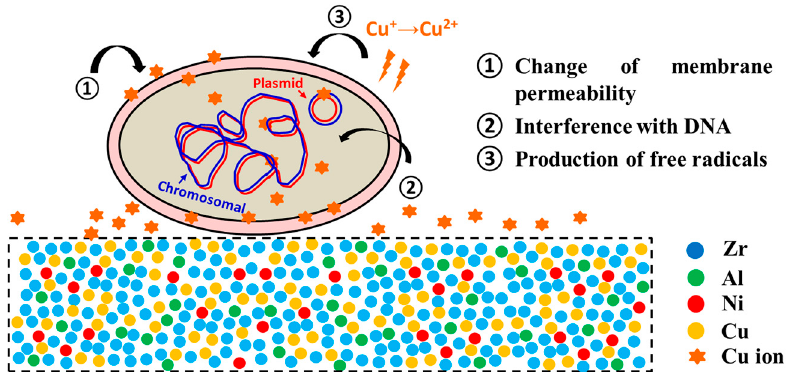
Figure 1. Representation of the contributing antimicrobial mechanisms of Cu ions released by a Cu bearing Zr-based bulk metallic glass [11].